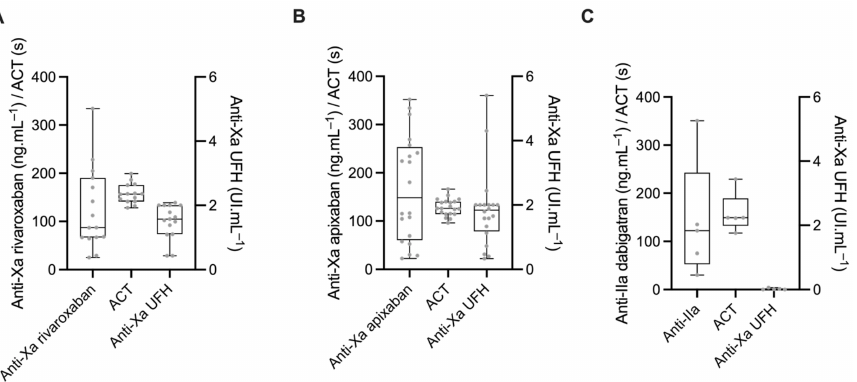
Figure 1. Specific anti-Xa/IIa activity, activated clotting time (ACT), and anti-Xa activity calibrated for unfractionated heparin (UFH) in patients treated with either rivaroxaban ( A ), apixaban ( B ), or dabigatran ( C ).